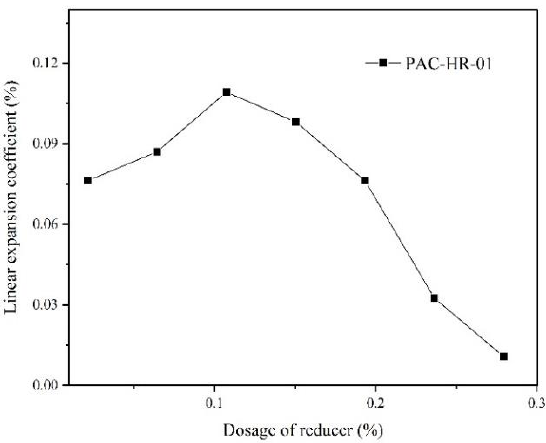
Figure 5. Effects of different kinds of retarders on the linear expansion coefficient of dental gypsum at different dosages (ww −1 ).